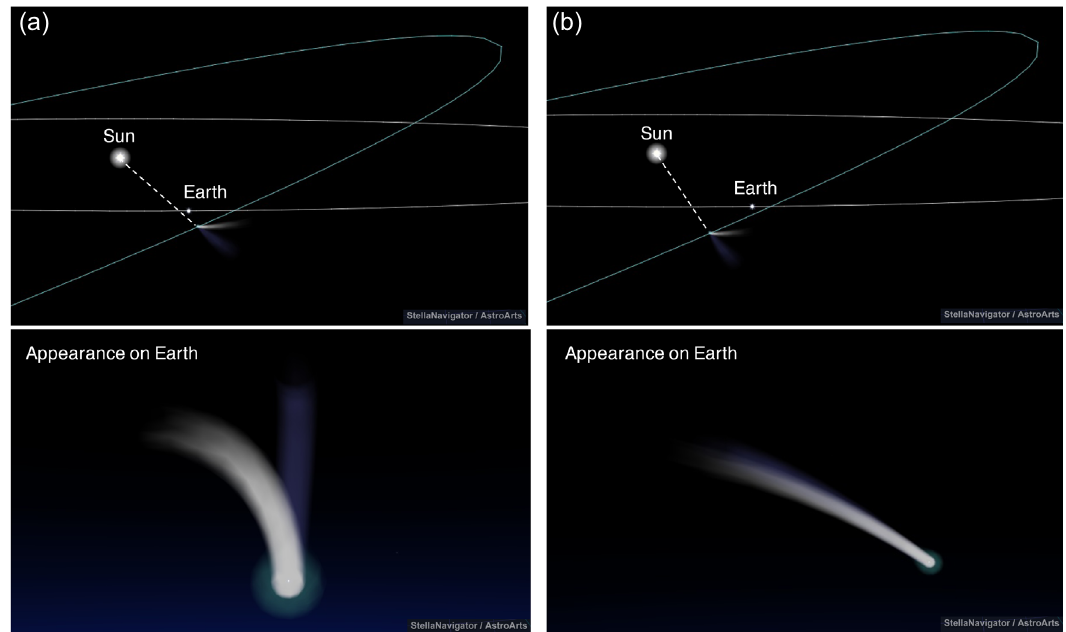
Fig. 1. Directions of two tails (plasma and dust tails) of a comet in comparison with the Sun and its orbit, with courtesy of Stellar Navigator 11/ AstroArts. These diagrams show that the plasma tail extends to the quasi-antisolar direction and that the dust tail curves according to the orbit of the associated comets. While comets have plasma and dust tails, up to the relative angle with the Earth, two tails are visible (a) or apparently overlap with each other and cannot be distinguished by the terrestrial observers (b).